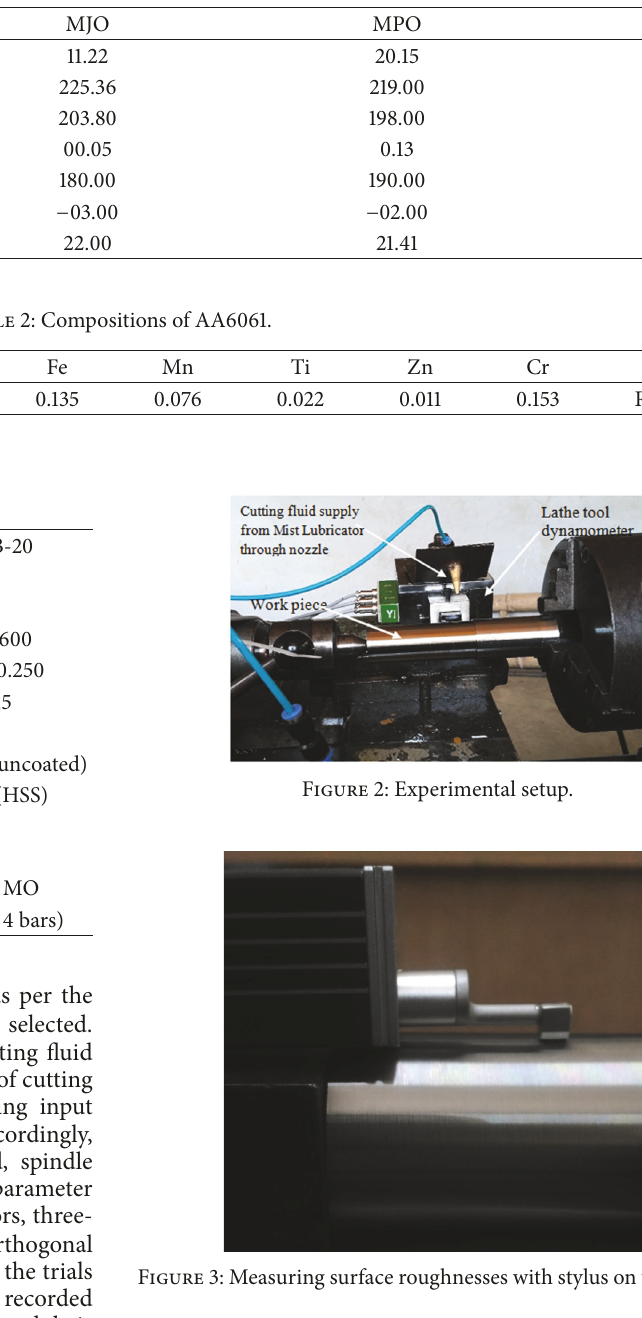
Table 1: Physicochemical properties of vegetable oils, their modified versions, and mineral oil.